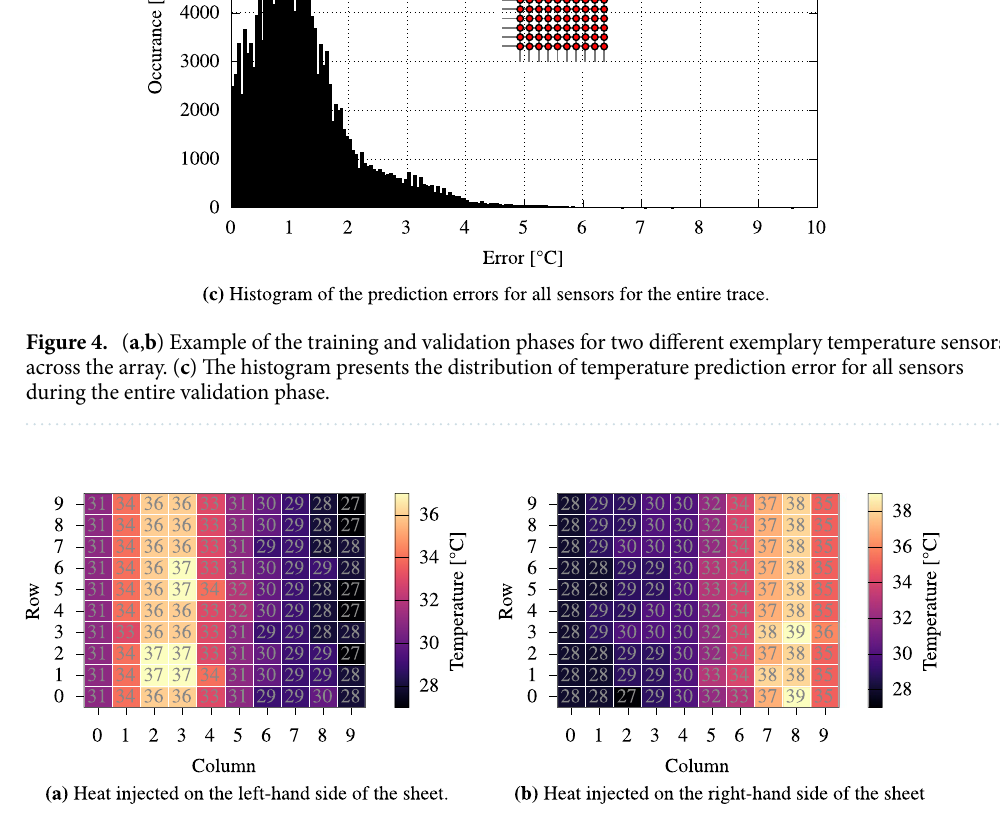
Figure 5. By using the micro heater sheet (Fig. 1c), we are able to inject heat in arbitrary regions of the sensor